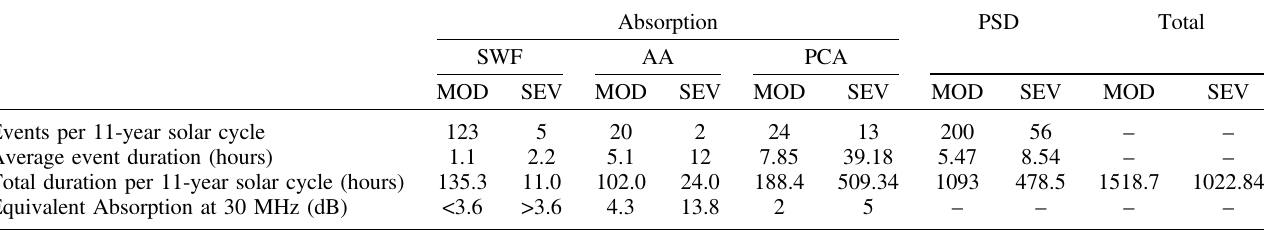
Table 3. Events per 11-year solar cycle, average event duration, total duration per 11-year solar cycle, and equivalent absorption at 30 MHz for absorption (SWF, AA, and PCA) and PCA